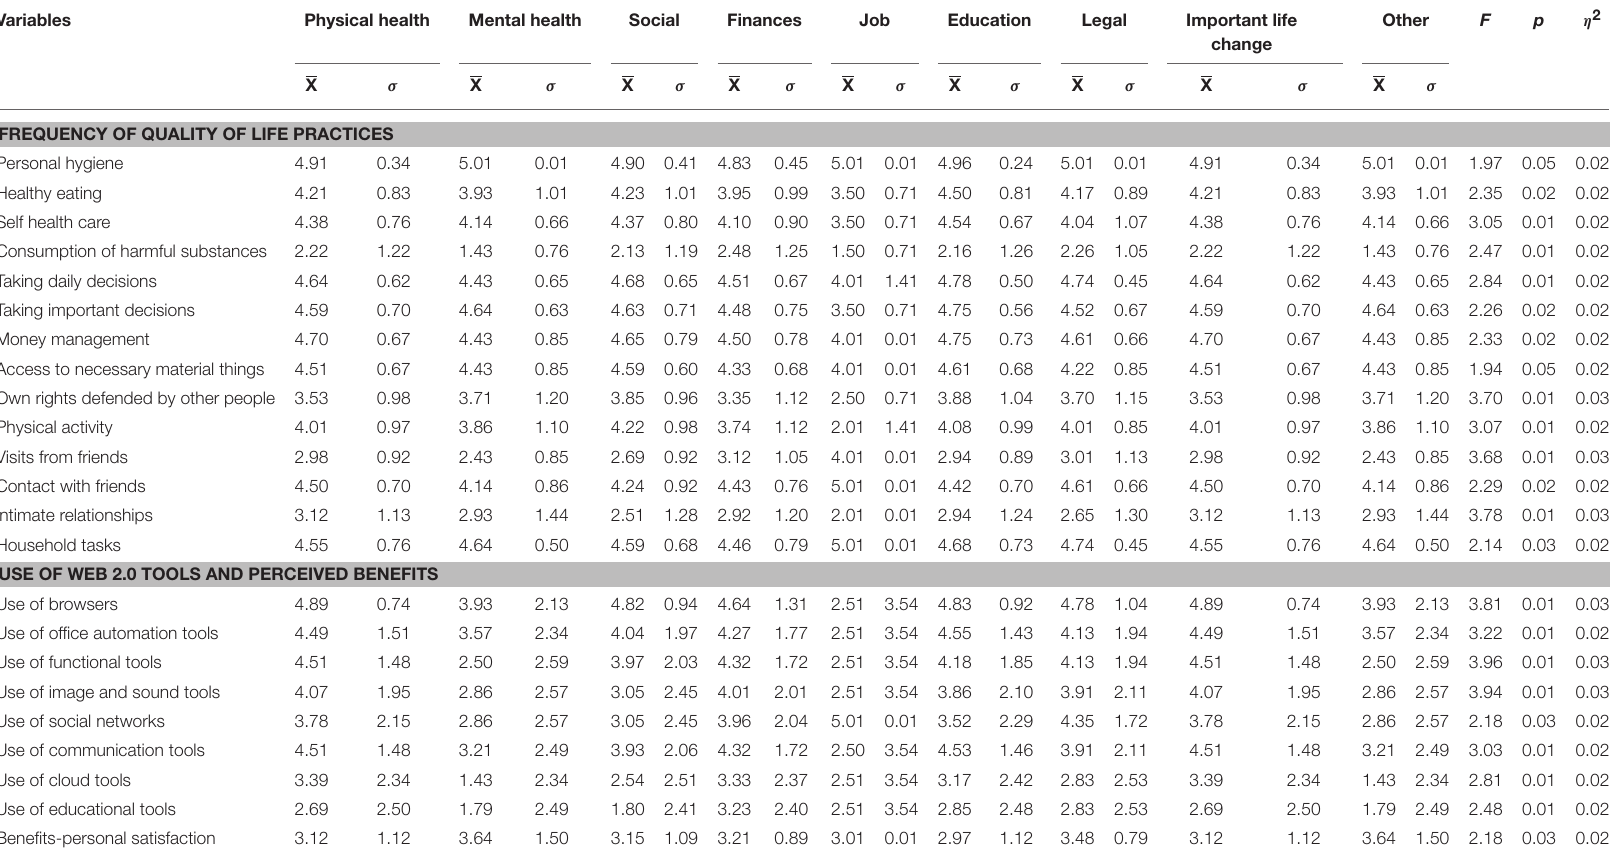
TABLE 3 | Differential patterns in quality of life practices, use of web 2.0 tools, and perceived benefits according to favorable life experiences.